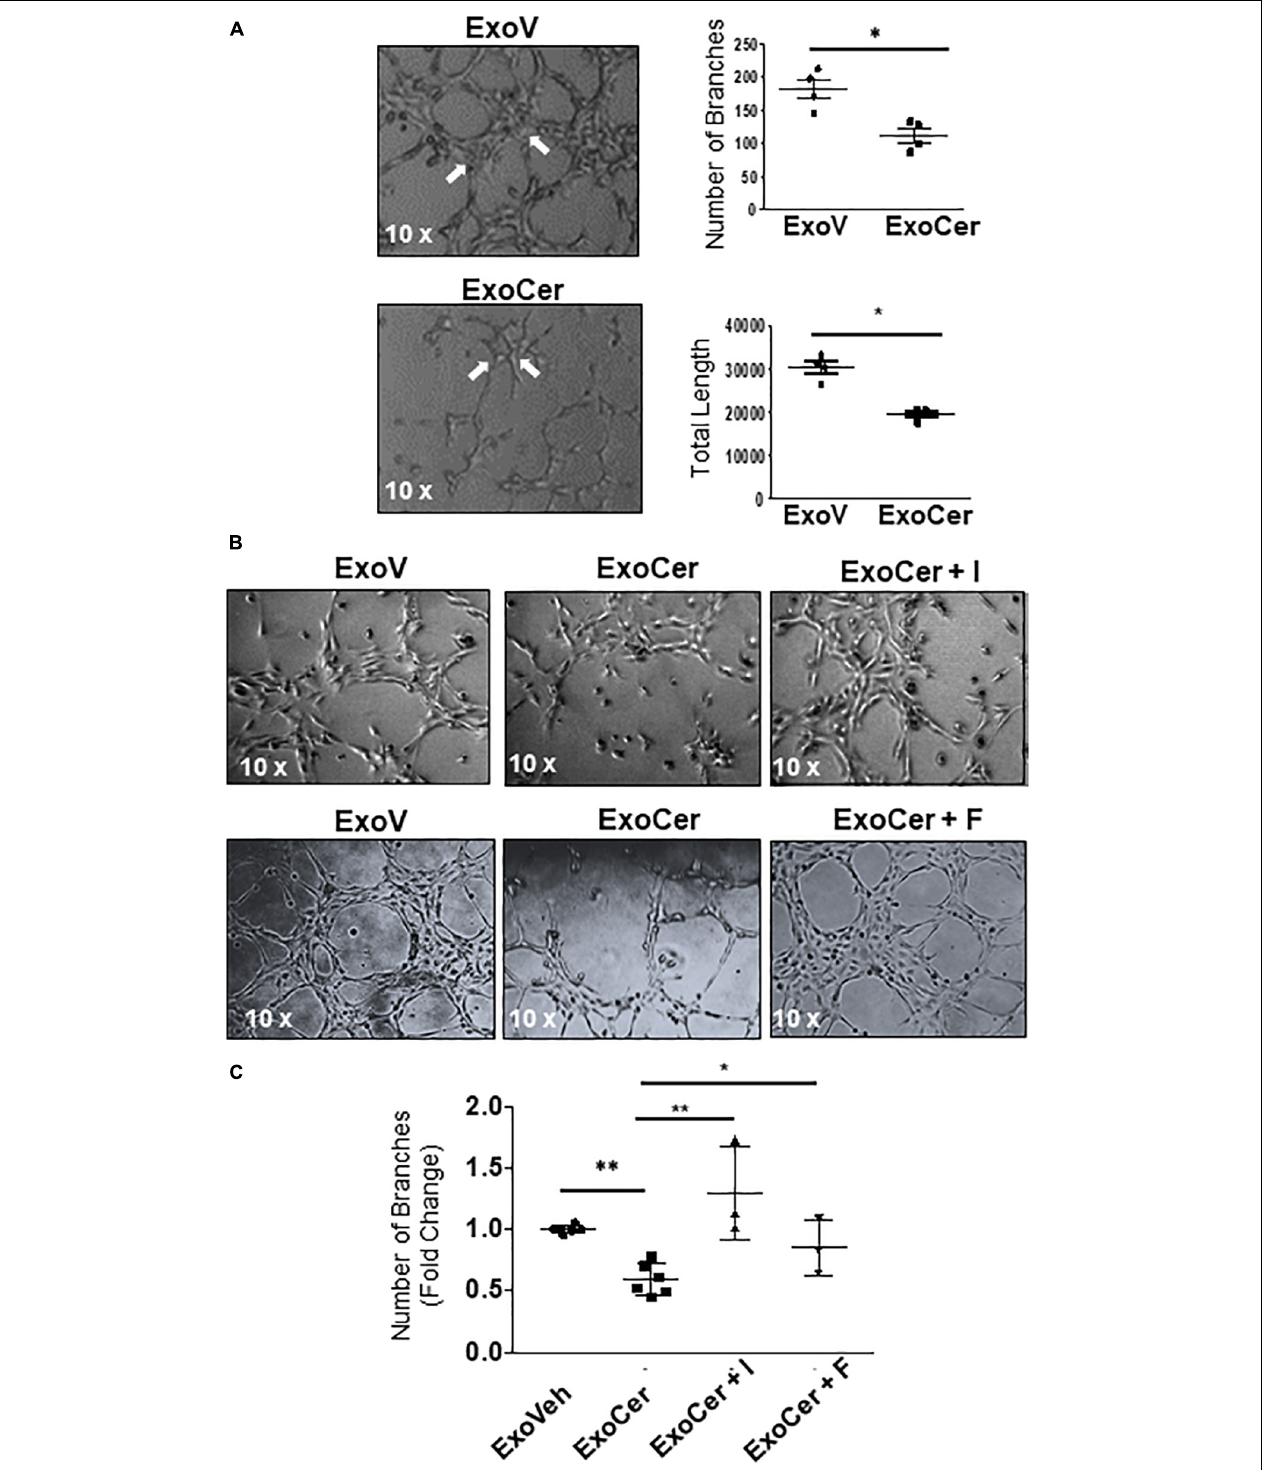
FIGURE 9 | Active SMPD1 in exosomes from JEG3 cells exposed to ceramide affect endothelial angiogenesis. (A) Angiogenesis assay of HMVEC treated with 2 × 10 6 ExoV or ExoCer ( N = 4 separate experiments). Tube formation was documented after 3 h of treatment by quantification of number of branches and the total length of the segments of the network. Arrows indicates the main branches. Data are expressed as mean ± SEM ( N = 4 separate experiments). (B) Tube formation assay of HMVEC cells treated for 3 h with ExoV or ExoCer in presence or absence of 25 µ M Imipramine (I) or 10 µ M Fluoxetine (F) and accompanying quantification (C) of tubular branches. Data are expressed as mean ± SEM ( N ≥ 3 separate